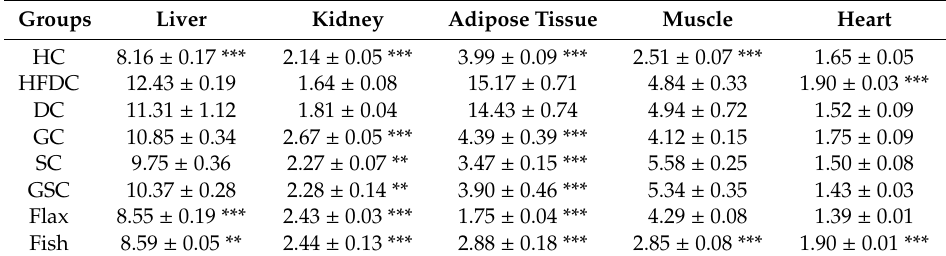
Table 4. Measurement organ weight